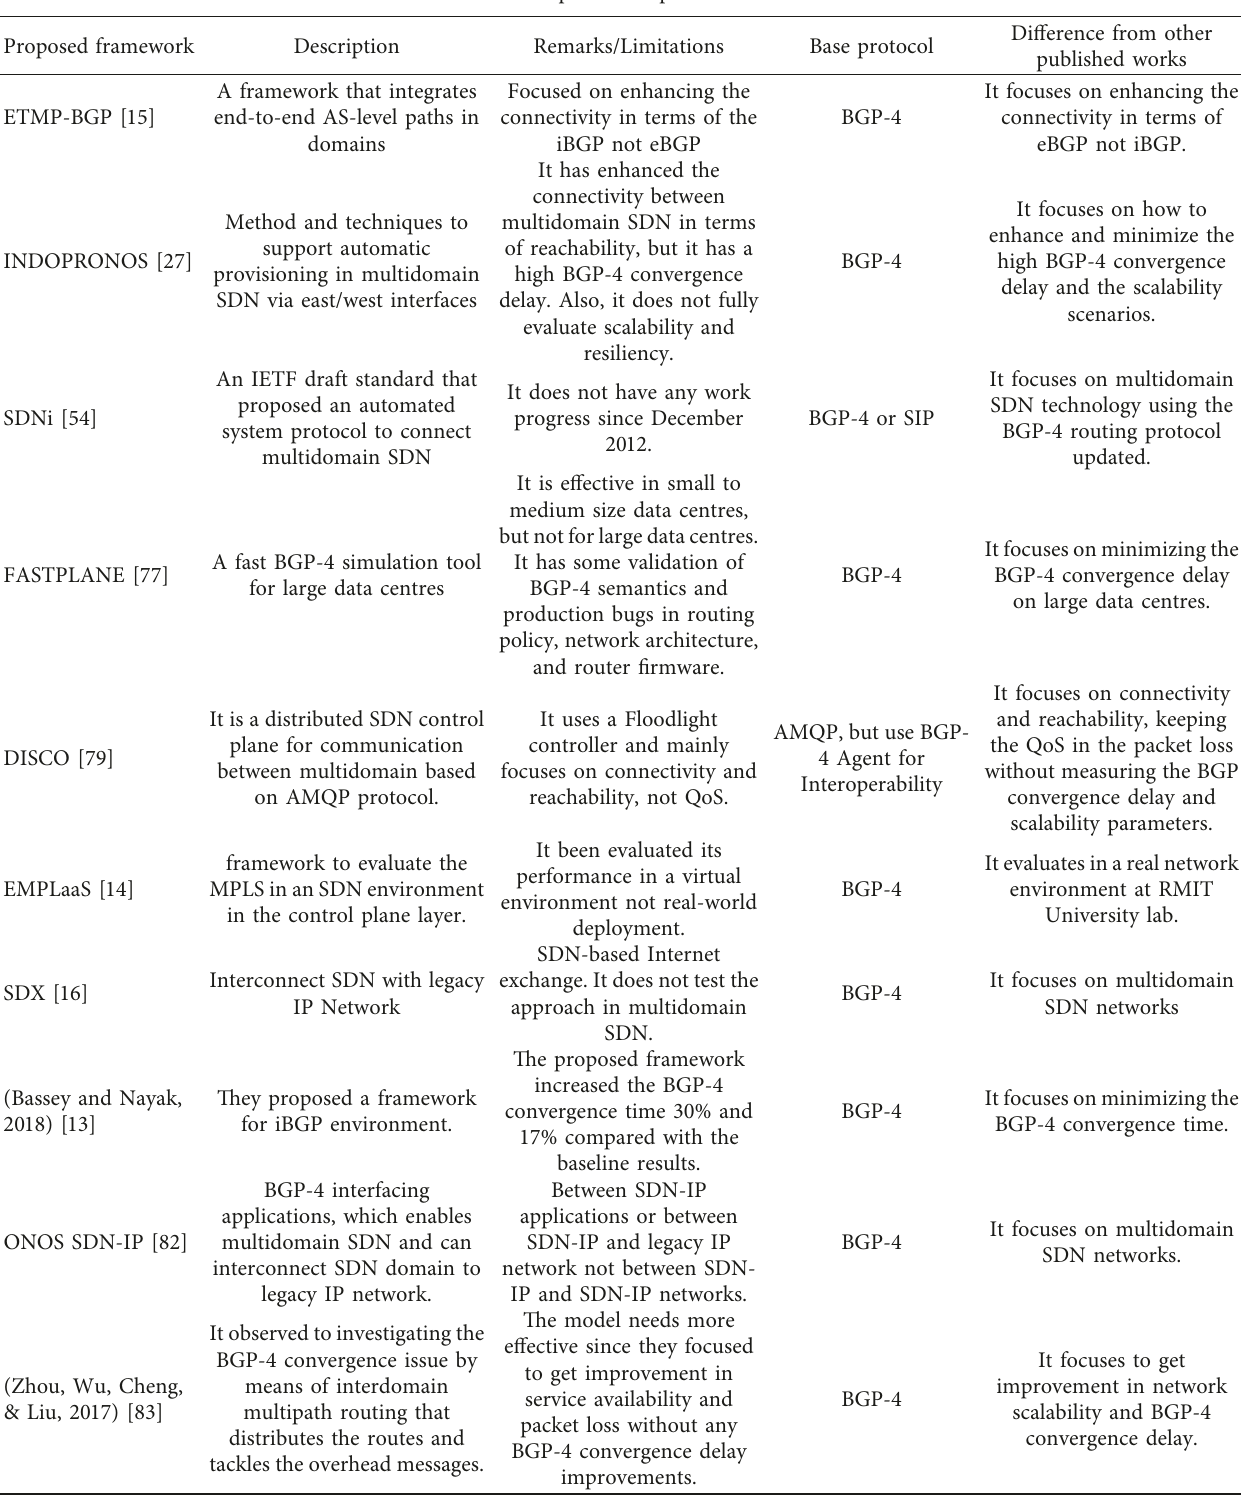
Table 3: Comparison of published